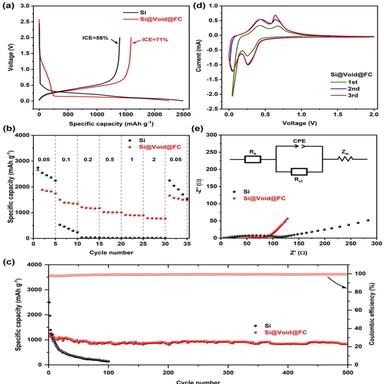
(a) The initial charge− discharge curves of Si and Si@Void@FC electrodes at the current density of 0.5 A g− 1 , (b) Rate performance curves of Si@Void@FC electrode at various current densities (0.05, 0.1, 0.2, 0.5, 1, and 2 A g− 1 ) sequentially for five cycles, (c) Cycling performances of Si and Si@Void@FC electrodes, (d) Cyclic voltammetry of Si@Void@FC electrode of the first three cycles. (e) Nyquist plots of Si and Si@Void@FC electrodes. The illustration depicts the impedance spectra equivalent circuit.